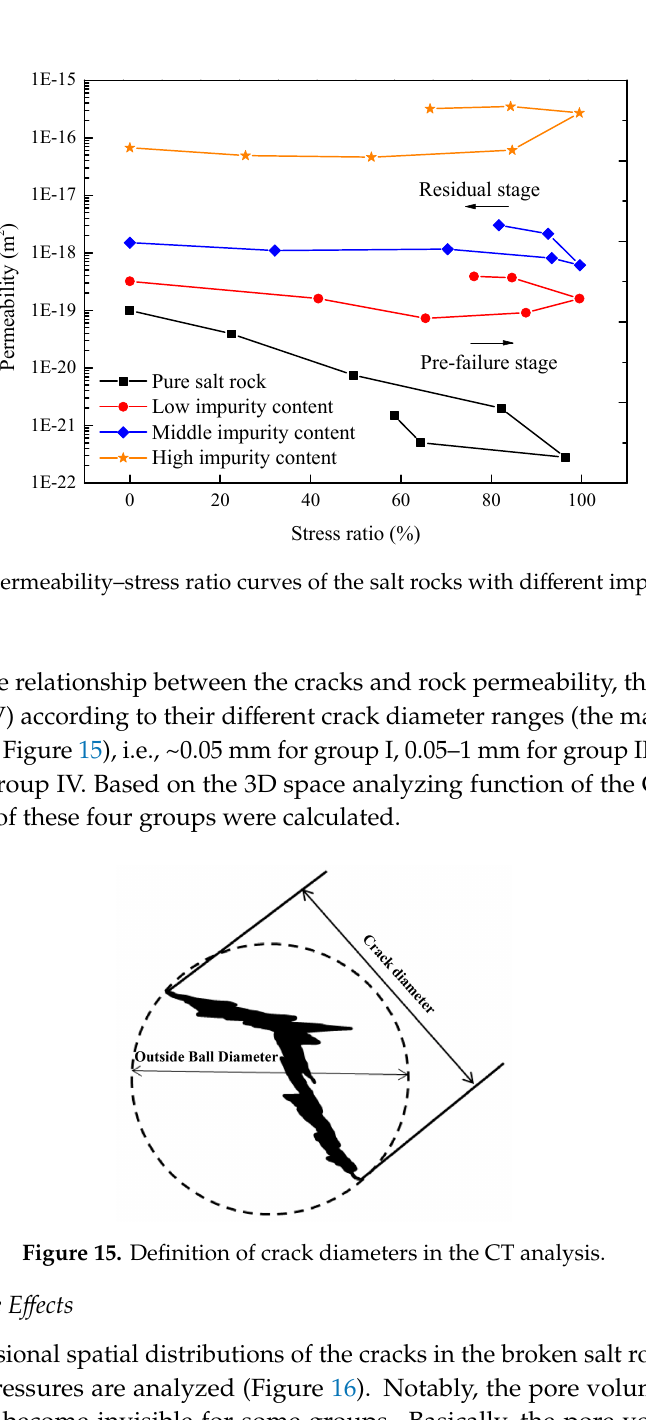
rock. From Figure 9, we can see that the failure modes of the salt rock specimens with different impurity